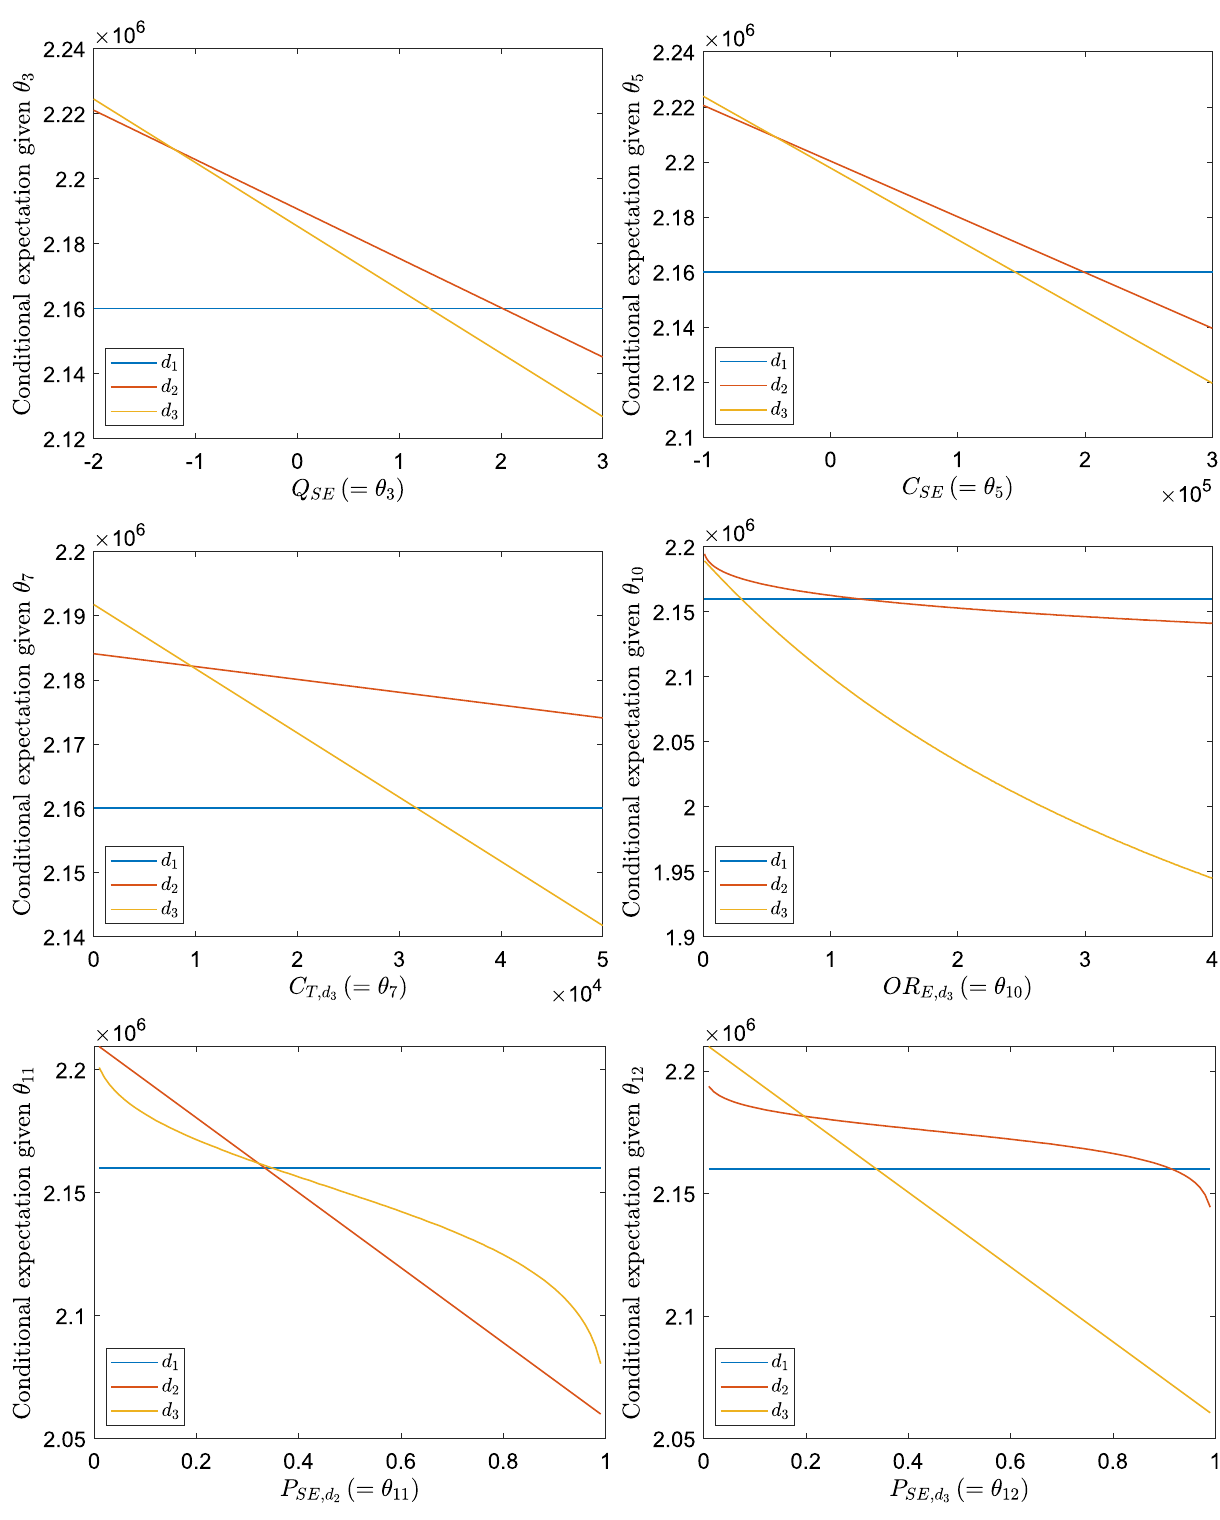
θ ) as functions of θ j for d θ j [ f d ( ] − j |